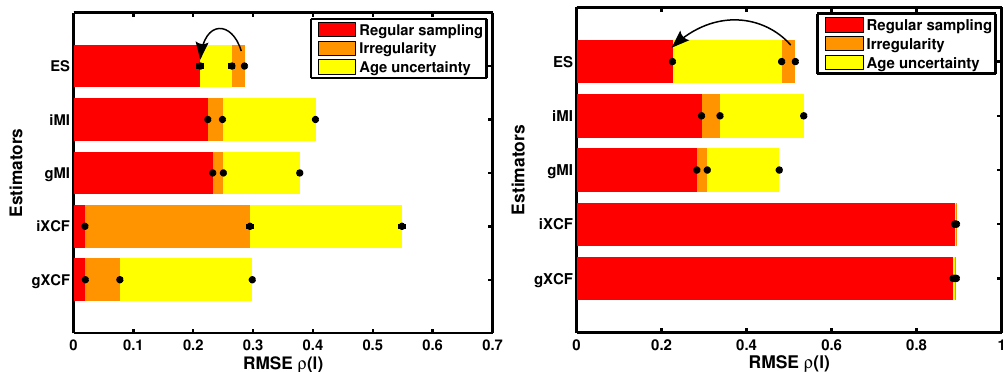
Fig. 6. Attribution of the uncertainty to its sources for (a) the linear CAR model and (b) the nonlinear TAR model: general (estimator) error in red, error introduced via irregular sampling (orange) and additional error due to the age uncertainty (yellow). The source-dependent RMSE was averaged over the second through to fifth imprecision levels given in Figs.4d and 5d, as these correspond to the error levels most likely found in real-world studies. Errorbars indicate the associated standard deviation. For event synchronization the RMSE is lower for irregular than regular sampling, folding the irregular part of the bar backwards.